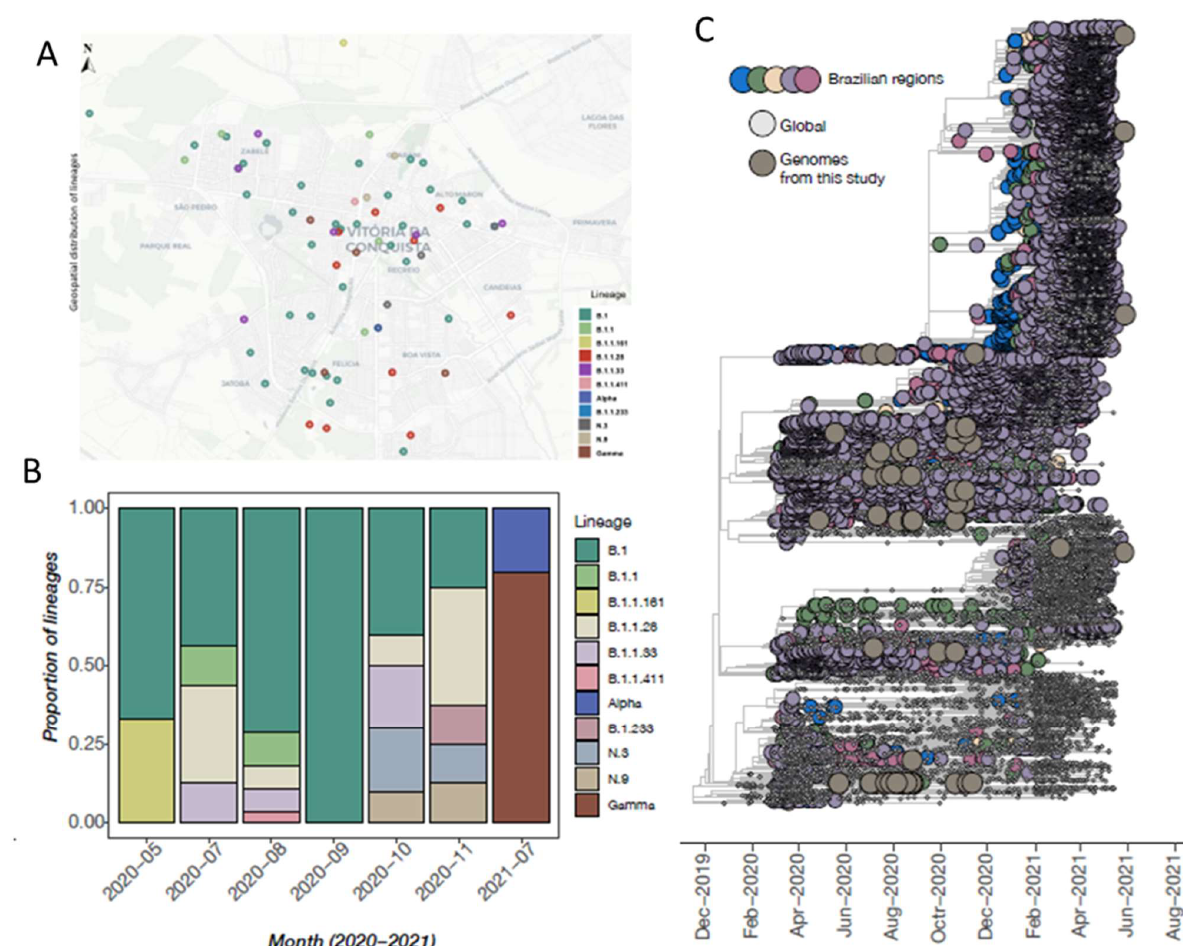
Figure 2. SARS-CoV-2 sequencing in Vitória da Conquista, BA, Brazil. ( A ) Distribution of sequenced samples among the 34 municipality districts; ( B ) Lineages found in the municipality between May 2020 and August 2021; ( C ) Phylogenetic analysis and lineage diversity between December 2019 and August 2021.